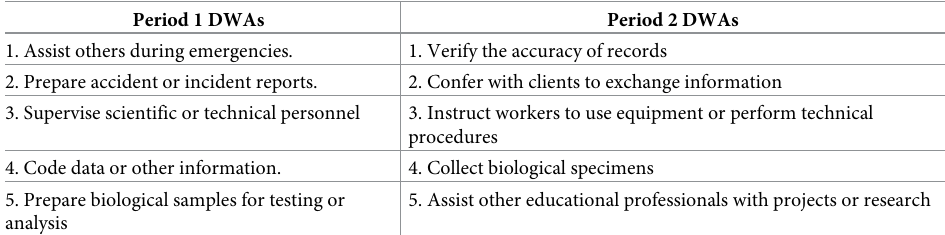
Table 7. Top 5 in-demand DWAs in the US healthcare